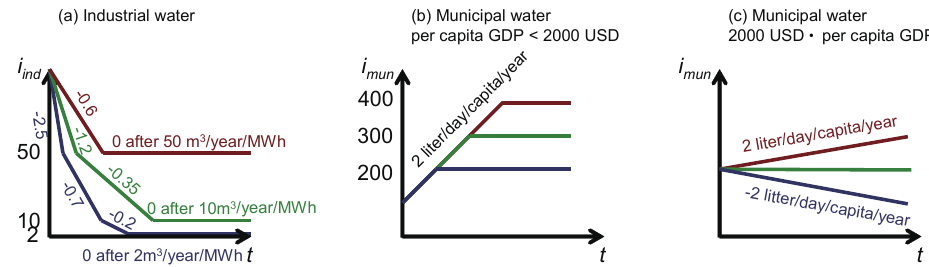
Fig. 6. Schematic diagram of intermediate water use scenarios for (a) industrial water withdrawal, (b) municipal water withdrawal for countries with per capita GDP < 2000 USD, and (c) for countries with 2000 USD ≤ per capita GDP. Blue for High Efficiency, green for Medium Efficiency, and red for Low Efficiency scenario.